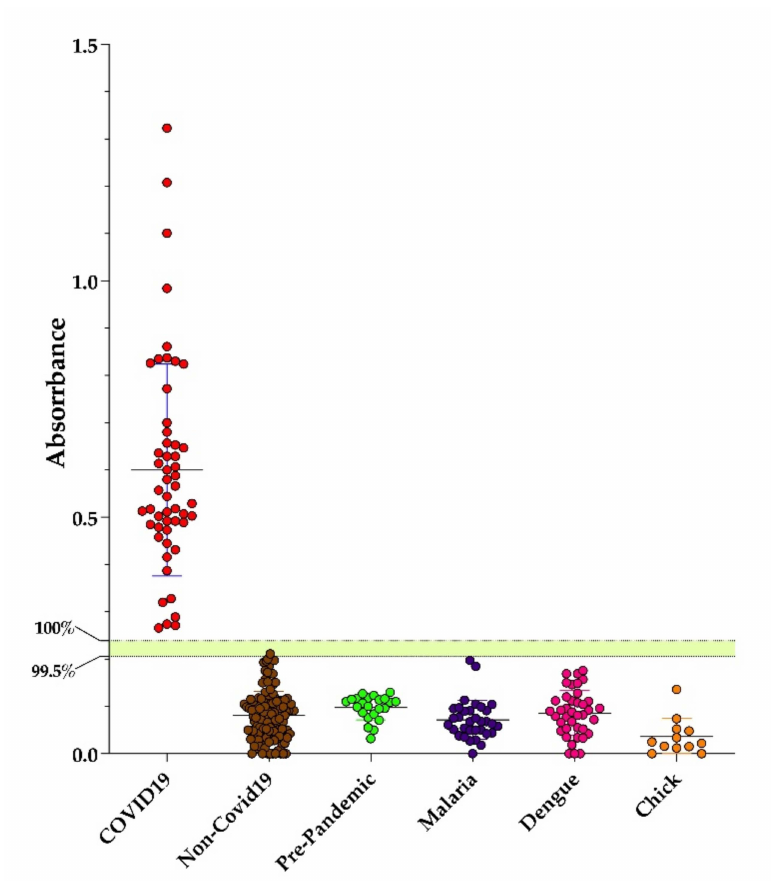
Figure 3. Performance of Dx-SARS2-noRBD as a target in an ELISA. ELISA plates were prepared overnight with 200 ng of purified Dx-SARS2-noRBD protein before performing an immunoassay to detect human IgG in sera collected from patients confirmed with COVID-19 ( n = 52). Controls included non-COVID-19 patients ( n = 127) and sera collected before the start of the pandemic from healthy individuals (pre-pandemic, n = 23) as well as patients diagnosed with malaria ( n = 33) dengue ( n = 39), and chikungunya ( n = 12). The median with the SD is shown. The two cutoffs were determined from ROC analysis. Table 2. Cutoffs for ELISAs with Dx-SARS2-RBD and Dx-SARS2-noRBD. Multiepitope